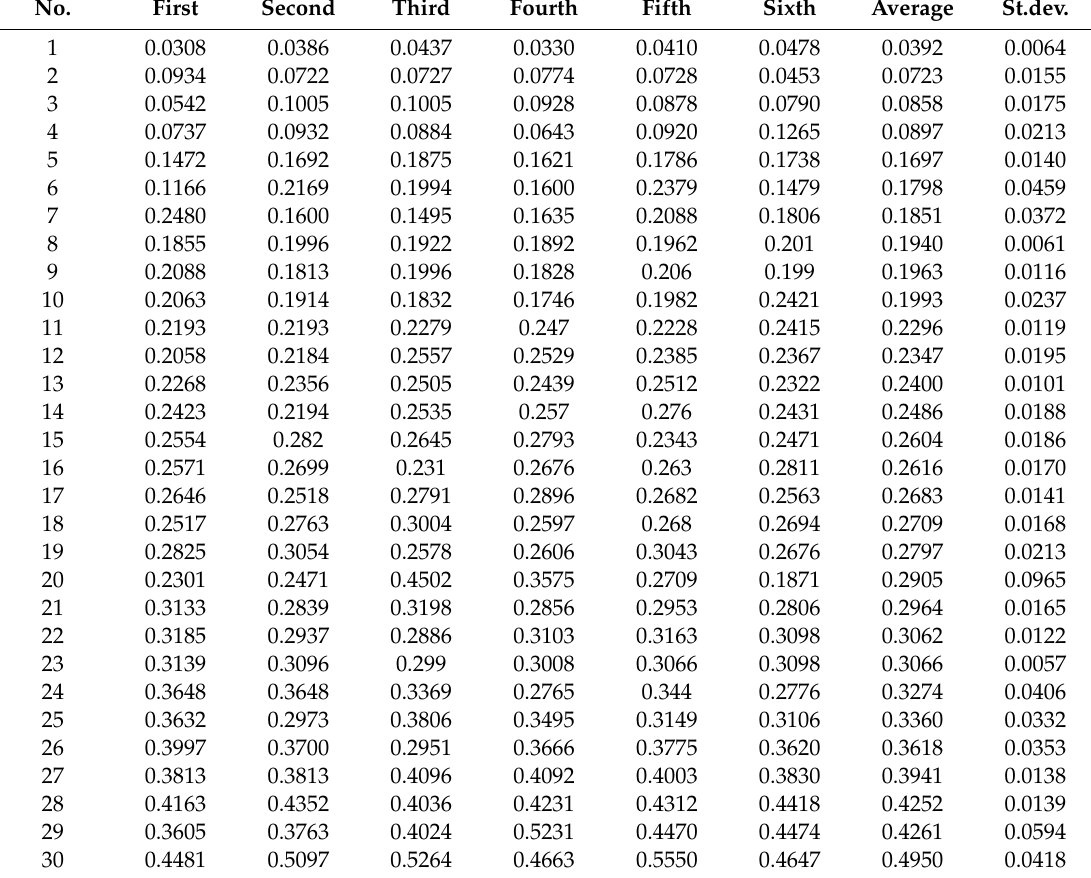
Table A1. Six roughness measurement (units: µ m ) made using stylus-based